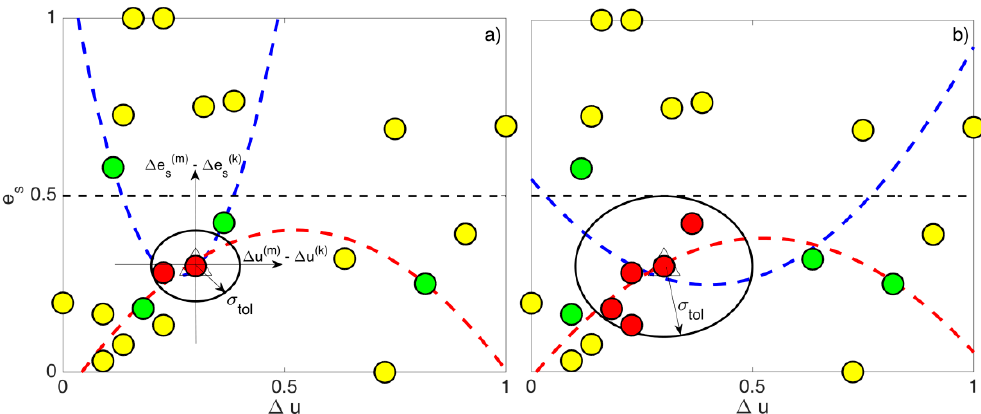
Figure 5. The effects of using of 2D DUPID algorithm to select adequate data for model construction for different values of σ tol : ( a ) σ tol = 0.1 and ( b ) σ tol = 0.2. The blue and red dashed lines in ( a , b ) are the obtained quadratic fits. The last point fed to the algorithm is marked with a triangle. The collected data used for testing consist of 20 random integer points drawn on the interval [0, 50] for ∆ u and [ − 70, 70] for e s . The data are normalized before it is fed to the algorithm. The black dashed line is zero error axis mapped in the normalized search space.